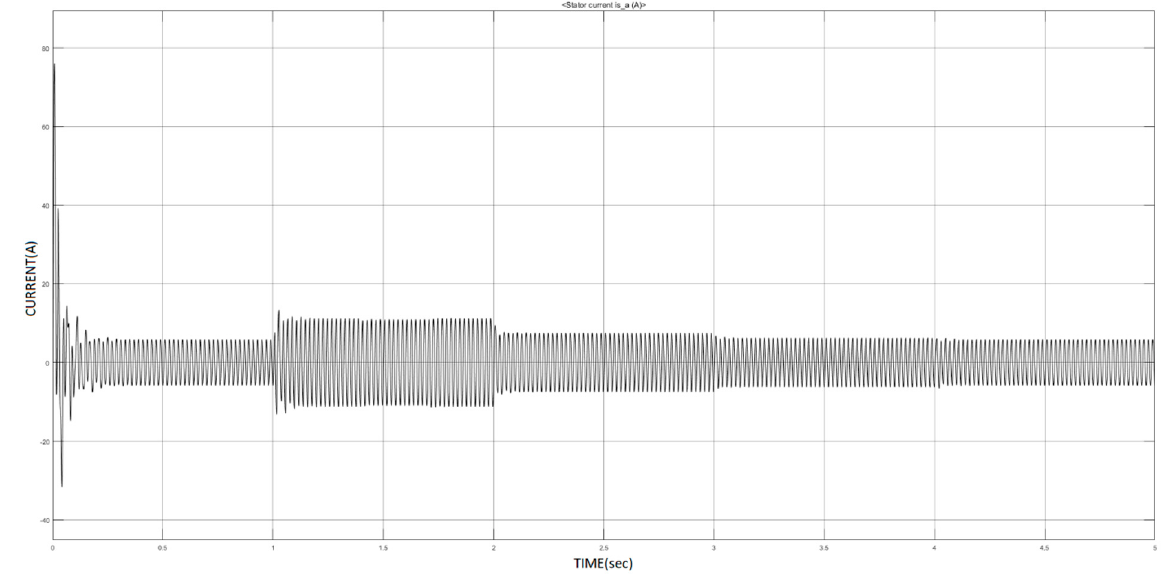
Figure 4. Time series of Current A during unrecognizable faulty operation.